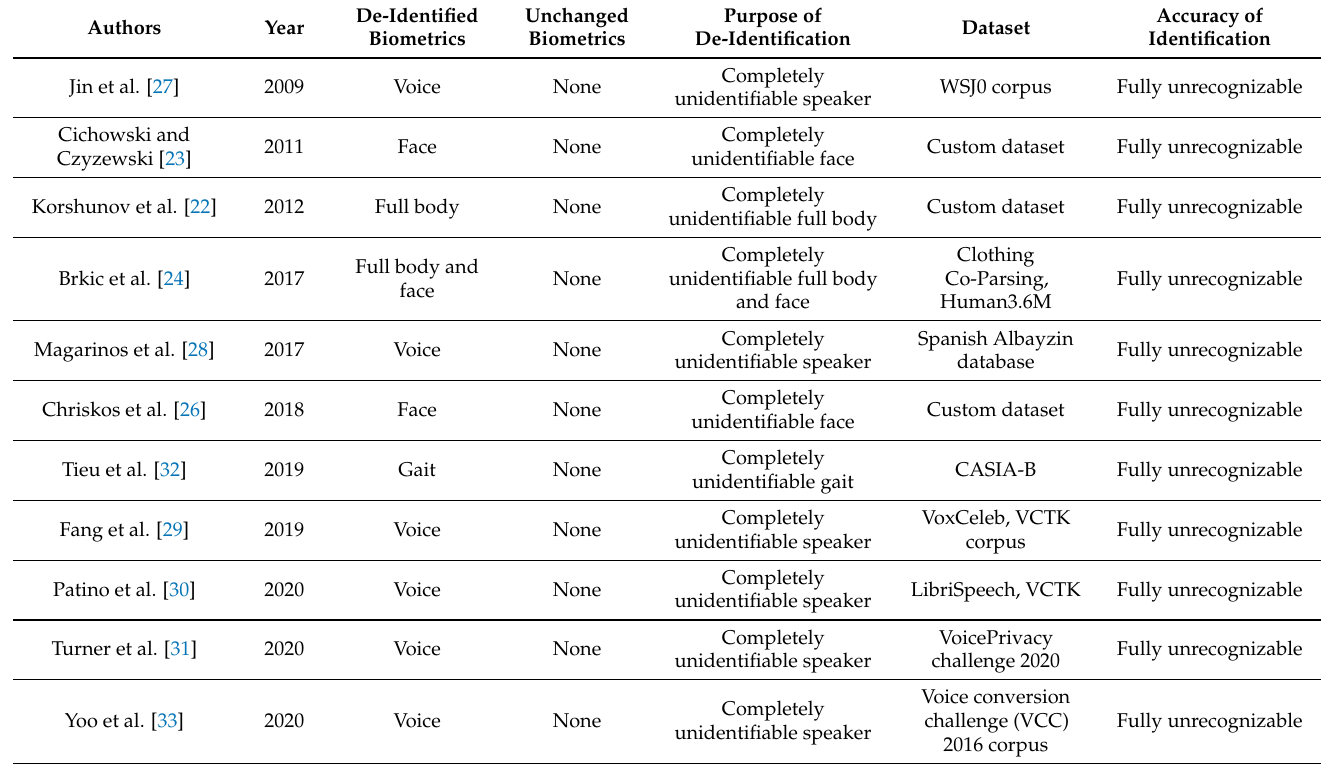
Table 1. Summary of complete de-dentification